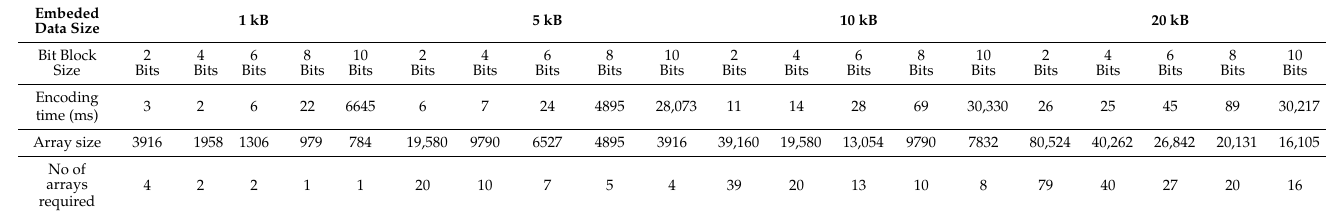
Table 2. OTA-Steganography CI-1 Results.